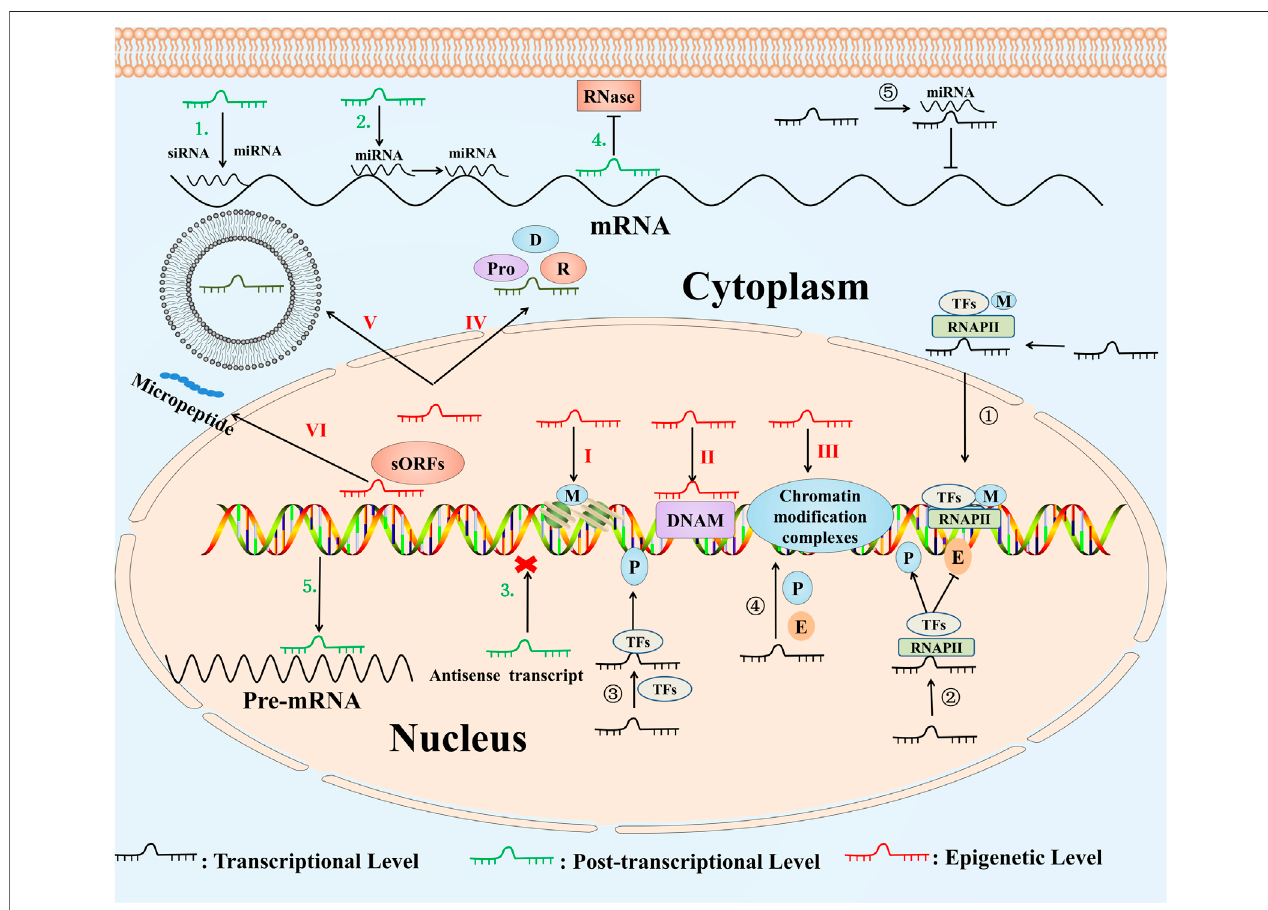
FIGURE1 | Functional molecular mechanisms of lncRNAs. ① LncRNAs change the location and modi fi cation of TFs (Hu et al., 2014). ② LncRNAs regulate the combination ofthe TFs, RNA polymerase Ⅱ and the promoter, enhancer (Wang and Chang, 2011). ③ LncRNAs interact with DNA asa platform for TFs (Yin et al., 2015). ④ LncRNAs actascompetitiveendogenous RNAs(Cesana et al.,2011). ⑤ LncRNAs promotermay act ascis-acting enhancer elements (Liu et al.,2021b).1)LncRNAs act as the precursor for siRNAs or miRNAs (Steck et al., 2012). 2) LncRNAs regulate the distribution of miRNA (Nachtergaele and He, 2017). 3) LncRNAs act as antisensetranscripts(Liuetal.,2021a).4)LncRNAsformthedouble-strandedRNAcomplexbybindingtomRNAs(Yuanetal.,2014).5)LncRNAsregulatetheselective splicing process of pre-mRNAs (Tripathi et al., 2010). I. LncRNAs regulate histone modi fi cation through affecting the modi fi cation factors (Houseley et al., 2008). II. LncRNAs bind to DNA modi fi cation to modify the DNA methylation (Song et al., 2021). III. LncRNAs bind to chromatin modi fi cation complexes to affect chromatin structure and remodeling (Pietropaolo et al., 2021). IV. LncRNAs locate molecules by binding to DNA, RNA and proteins as a “ guide ” (Camier et al., 1990). V. LncRNAs participate in the formation of exosomes (Zhang et al., 2021). VI. LncRNAs that contain sORFs can encode small peptide (Wang et al., 2019c). Abbreviations: